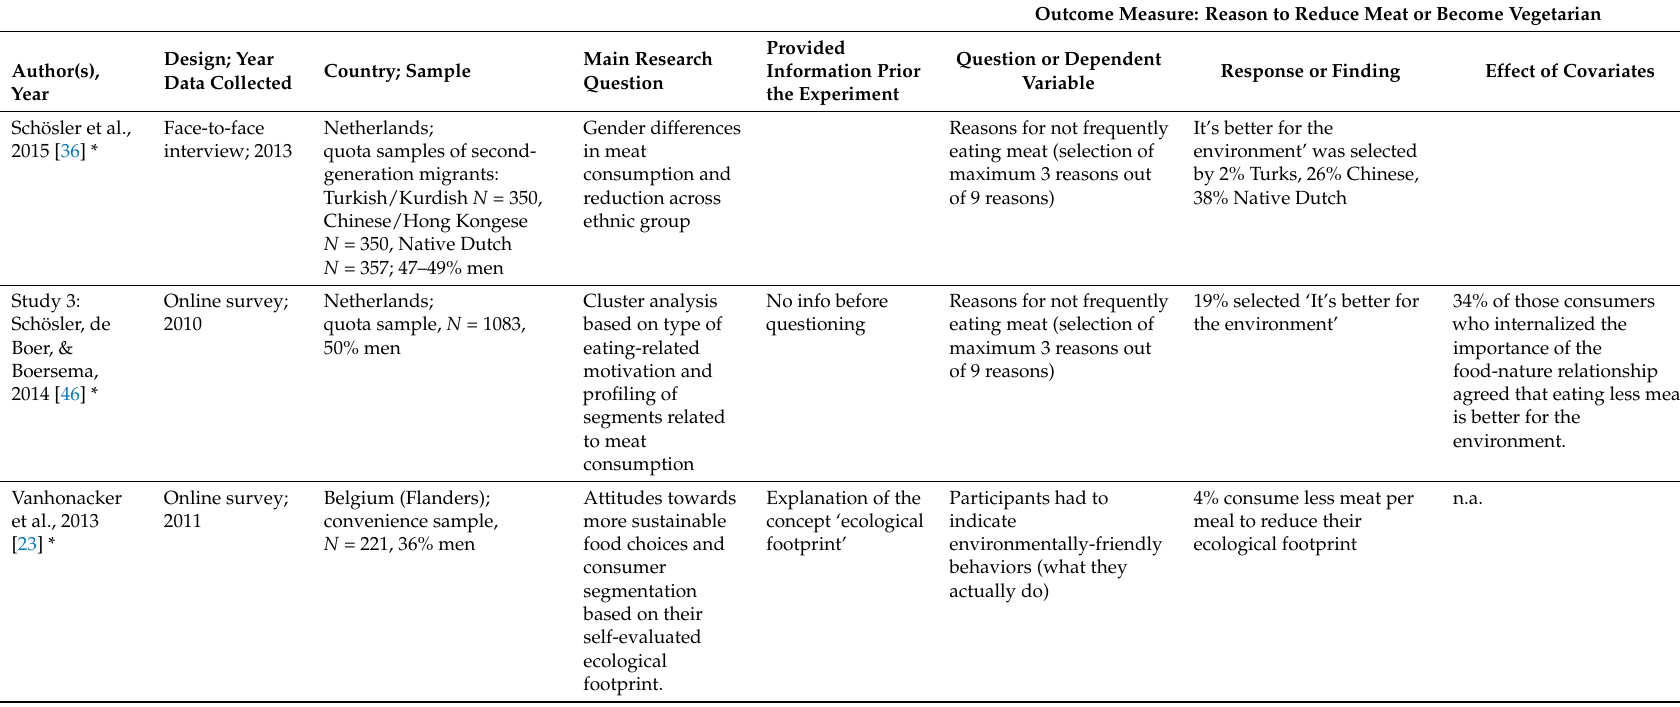
Table A3. Cont . Outcome Measure: Reason to Reduce Meat or Become